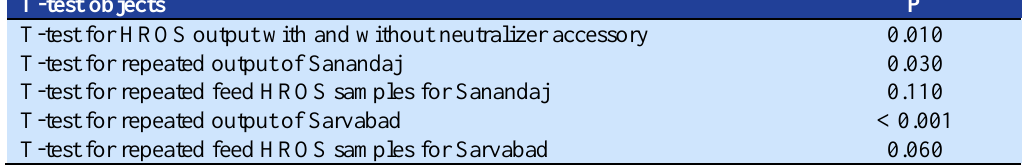
Table 2. T-test results for evaluation of neutralizer accessory and repeated samples T-test objects P T-test for HROS output with and without neutralizer accessory 0.010 T-test for repeated output of Sanandaj 0.030 T-test for repeated feed HROS samples for Sanandaj 0.110 T-test for repeated output of Sarvabad T-test for repeated feed HROS samples for